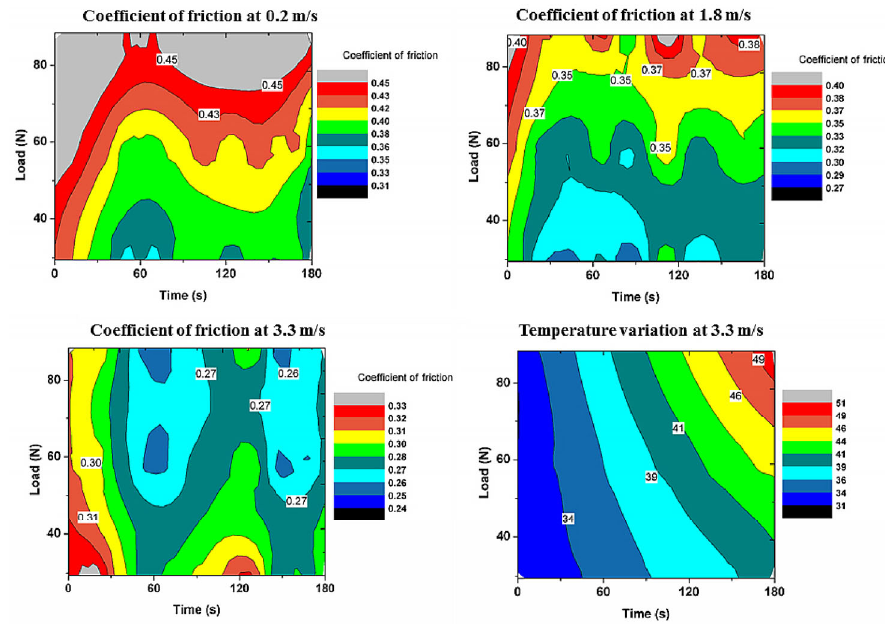
Fig. 5 Variation of the coefficient of friction and temperature for the W-I composition.